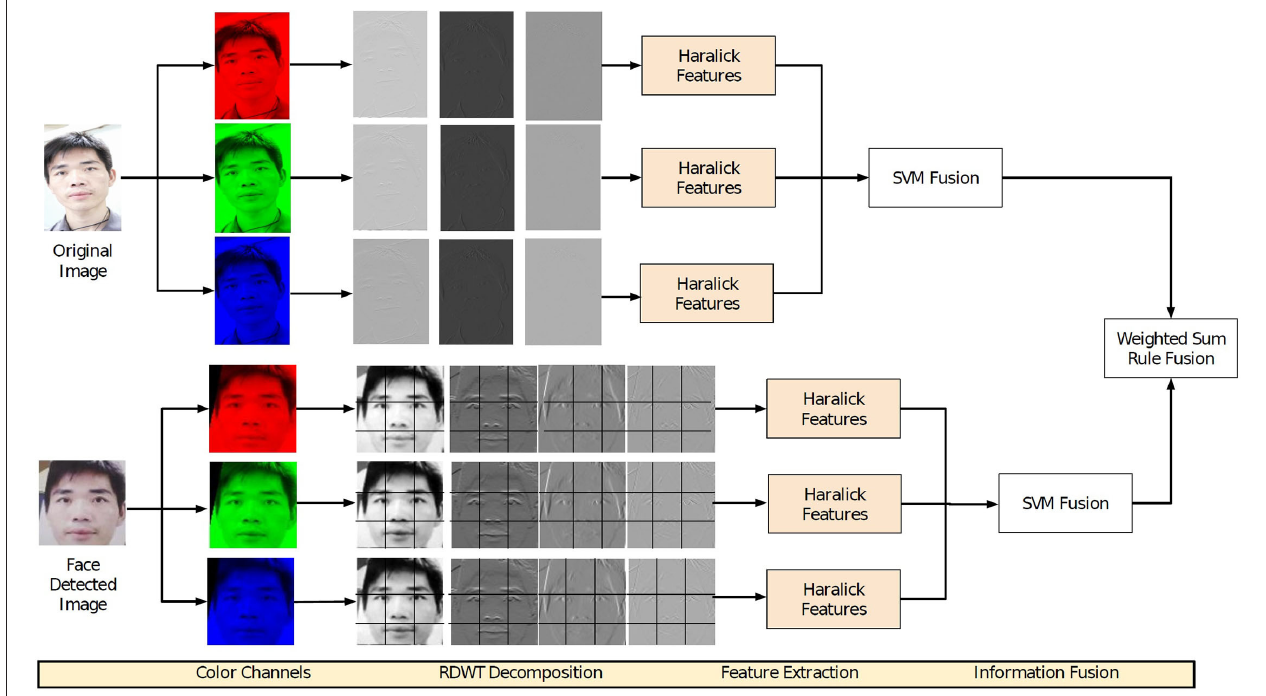
FIGURE 2 | Illustrating the proposed presentation attack detection pipeline.